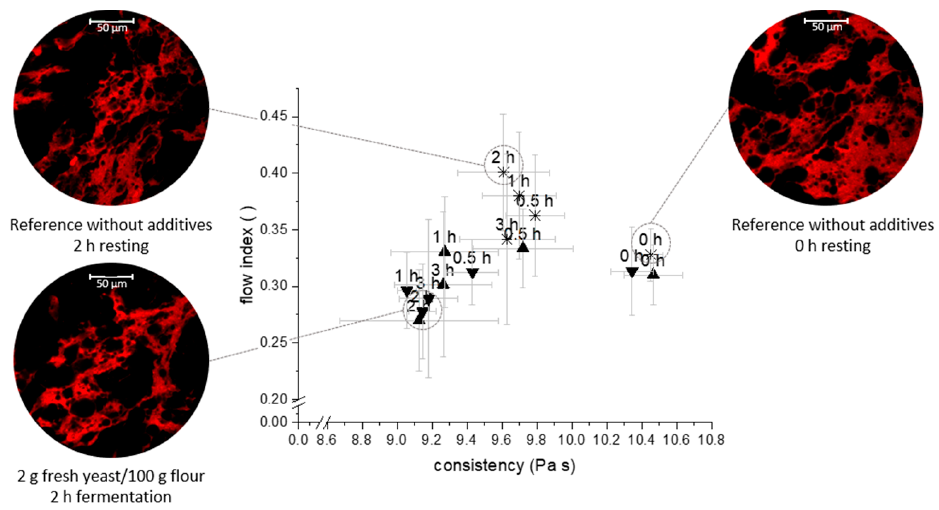
Figure 3. Time-dependent effect of fermentation on the flow index n and consistency index K for ε b = 1.00. Selected micrographs (protein stained with Rhodamine B (red)) illustrate the corresponding dough microstructure. ( ) Reference without additives, ( ▲ ) 1 g yeast/100 g flour, ( ▼ ) 2 g yeast/100 g flour. The CLSM images are shown at a scale of Ø 225 µm. (n = 3, X ± STD).